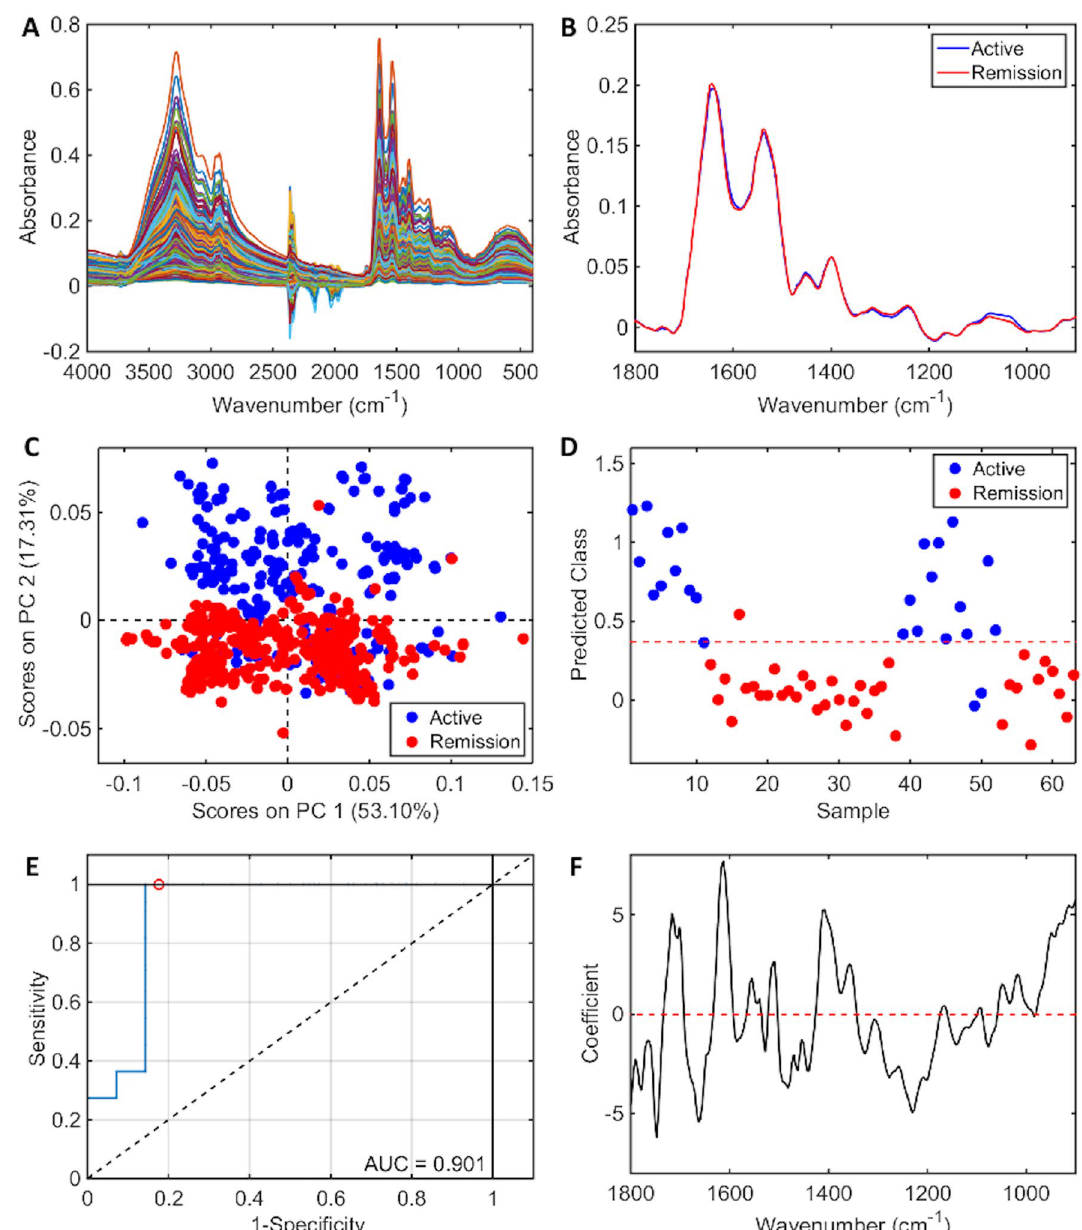
Figure 1. ATR-FTIR spectral classification of active disease vs. disease remission for plasma samples—( A ) Raw spectral data, ( B ) Pre-processed spectra, ( C ) PCA scores plot, ( D ) PLS-DA discriminant function graph, ( E ) ROC curve for PLS-DA, ( F ) PLS-DA coefficients for identification of spectral